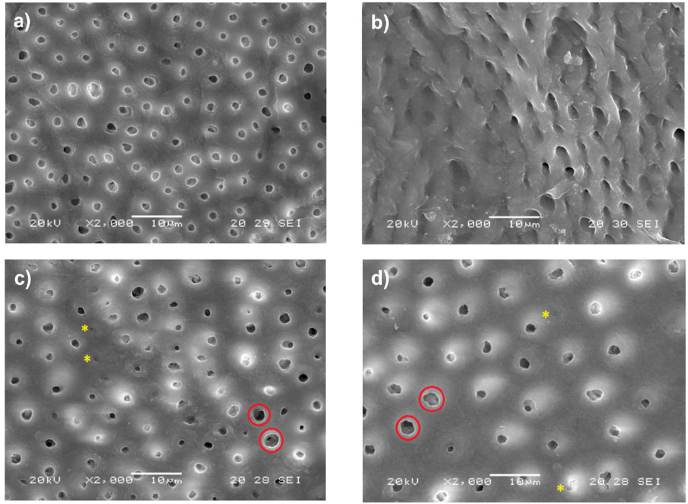
Figure 7. SEM images: ( a ) sound dentine, ( b ) carious dentine, ( c ) pHc (14 days), and ( d ) pHc (28 days). Red circles indicate some extensive opening tubules in both pHc groups. Yellow asterisks mark some occluded dentinal tubules in pHc 14 and pHc 28 groups. Scale bar: 10 µm. Table 2. The relative concentration of calcium (Ca) and phosphorus (P) on the dentine surfaces expressed as weight % for all experimental groups.